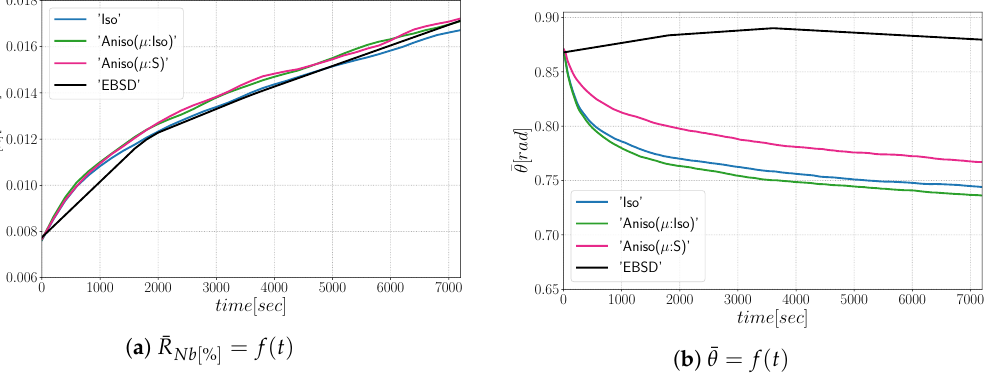
Figure 26. Mean values time evolution for the isotropic (Iso) formulation, anisotropic formulations with isotropic GB mobility (Aniso( µ :Iso)) and heterogeneous GB mobility (Aniso( µ :S)), and the experimental data (EBSD): ( a ) average grain radius, ( b ) average disorientation angle. Numerical results obtained from the initial immersed microstructure shown in Figure 25a and the GB5DOF code are used to define the GB